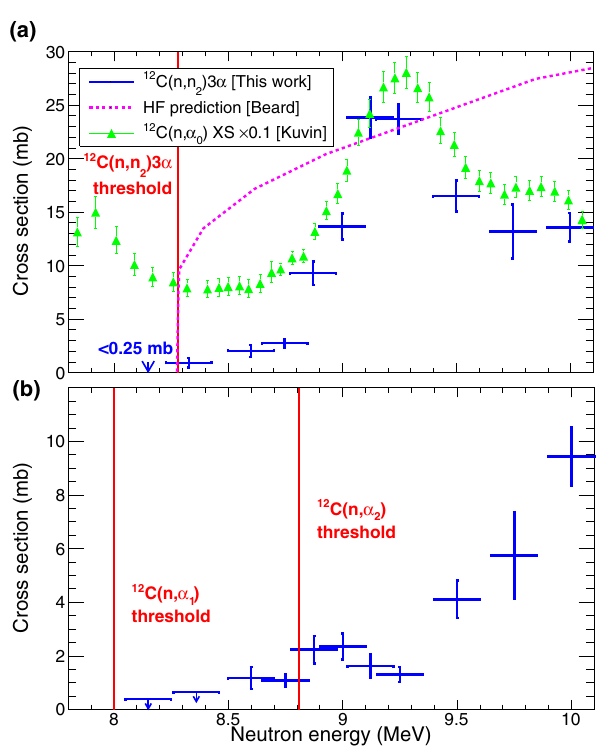
Fig. 2 Cross sections as a function of neutron energy for channels of interest. a 12 C( n , n 2 )3 α cross section (blue error bars) measured across the energy range of astrophysical interest with the Hauser-Feshbach (HF) predictions from ref. 3 overlaid in dashed magenta. The 12 C( n , α 0 ) cross section, scaled by a factor of 0.1 is overlaid with green triangles with data from ref. 8 (Table III) to show the similarity in form with the experimental data from this work. The cross section below the threshold was determined to be < 0.25 mb at the 95% C.L. where zero Hoyle events were observed. b 12 C ð n ; α 1 ; 2 Þ 9 Be ? cross section with the two thresholds for the centroid of the 9 Be ⋆ states marked by solid red lines. The lowest two energy points had zero observed events so the upper limit at the 95% C.L. is shown. For both plots, the x-axis error bars represent the total width of the neutron energy spectrum rather than its standard deviation due to the non-Gaussian nature of the beam energy pro fi le. The y-axis shows purely statistical error bars at the 1 σ level. presented in Supplementary Figs. 3, 4. The data for the latter are discussed in Sec. III E.